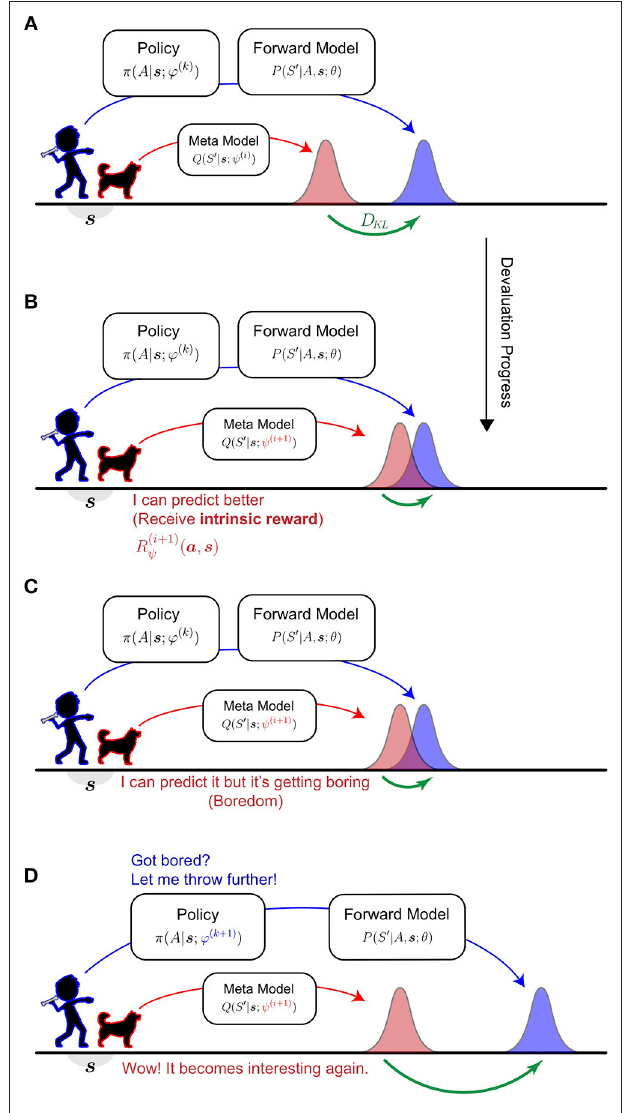
FIGURE 1 | Intuitive understanding of the Homeo-Heterostatic Value Gradients (HHVG) algorithm. (A) The algorithm can be interpreted as the cooperative interplay between a thrower (kid; blue) and a catcher (dog; red). The thrower is equipped with a forward model that estimates its aiming and is controlled by an action policy. Without knowing the thrower’s policy, the catcher (meta-model), in order to make good catches, infers where the thrower is aiming on average. (B) The catcher is interested in novel, unpredicted throws. Whenever the catcher improves its predictive power some intrinsic reward (devaluation progress) is generated. (C) As the catcher progresses further, similar throws become highly predictable, thus inducing a sense of boredom. (D) To make the interplay interesting again, the thrower is driven to devise new throws, so that the catcher can afford to make further progress. By repeating (A,B) the thrower has attempted diverse throws and known well about its aim. At the same time, the catcher will assume a vantage point for any